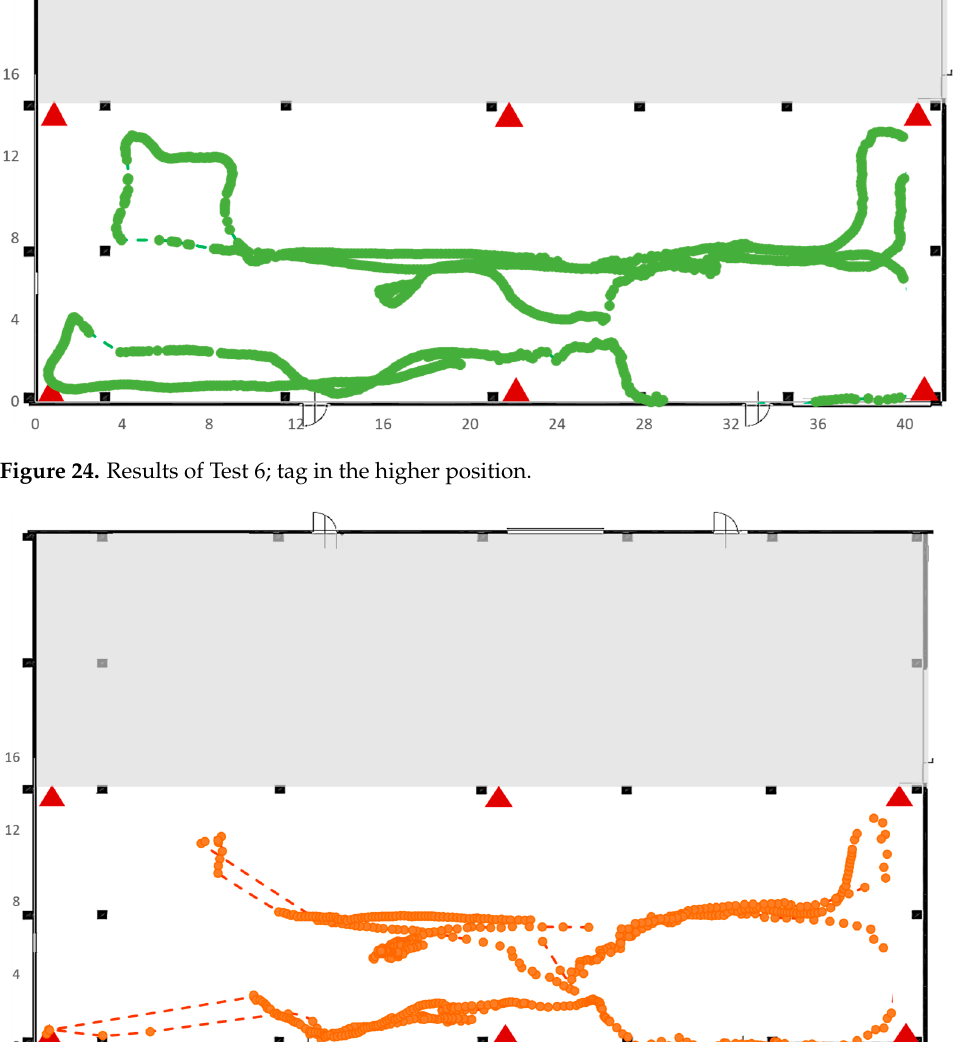
Figure 25. Results of Test 6; tag in the medium position.